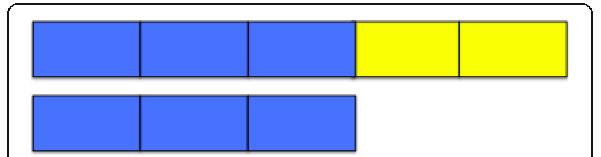
Fig. 2 Disembedding three-fifths from the whole